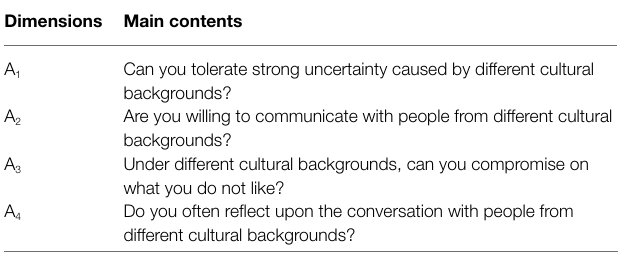
TABLE 1 | Cross-cultural competence measurement.